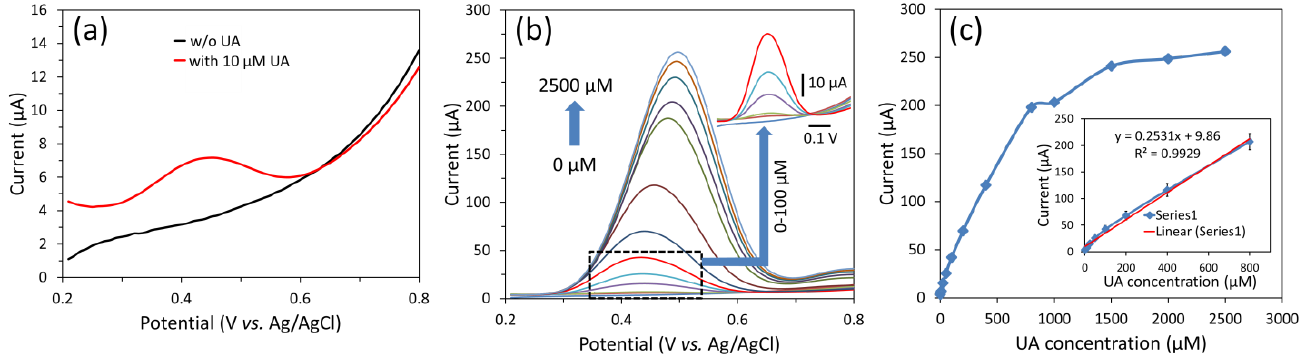
Figure 6. ( a ) DPV response curves recorded for cobalt oxide/GCE sensor in PBS without and with uric acid (10 µM), ( b ) DPV responses of cobalt oxide/GCE electrode with increasing uric acid concentrations (0 – 2500 µM), and ( c ) plot of current response vs. uric acid concentration showing linear and non-linear regions. Inset b shows the magnified DPV response curves for low-concentration uric acid. Inset c shows the calibration plot of the linear region (i.e., response vs. uric acid concentration).